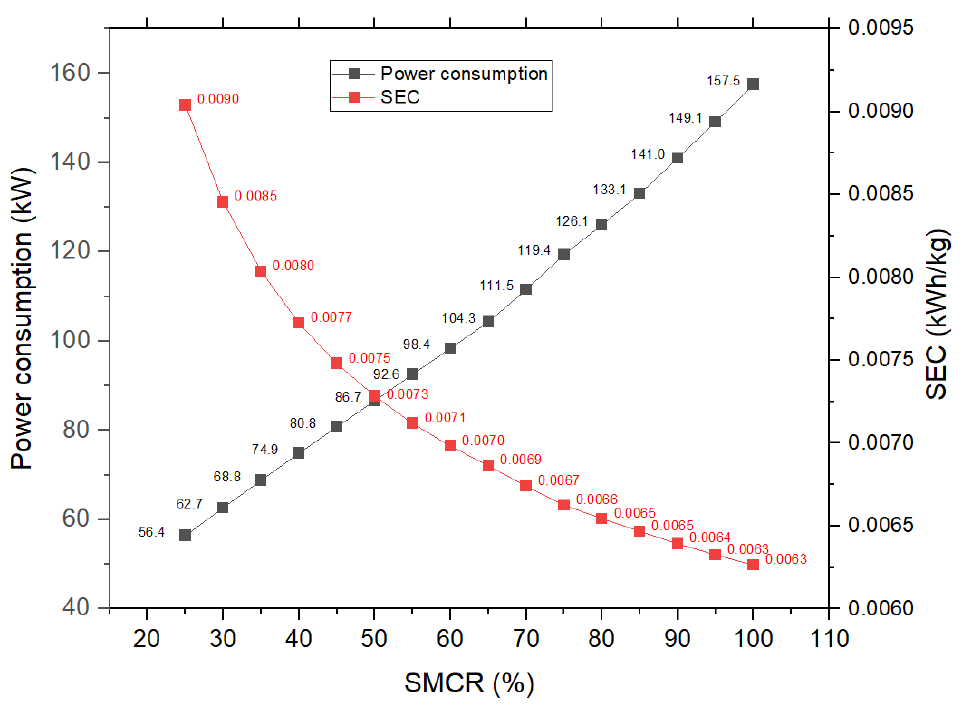
Figure 3. FSS power consumption for %